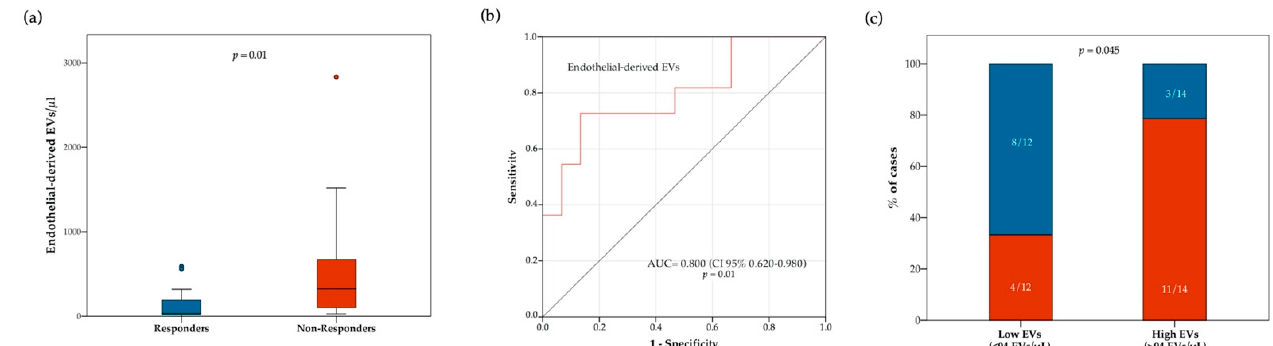
Figure 3. Relationship between response to ICIs and blood circulating endothelial-derived EV concentration at treatment baseline. In panel ( a ), boxplot diagram showing difference in median endothelial-derived EV concentration (horizontal black lines) between responders and non-responders. Two-tailed Mann–Whitney test was performed, and p value is shown. In panel ( b ), receiver operating characteristic (ROC) curve illustrating predictive abilities on ICI response of blood circulating endothelial-derived EVs. In panel ( c ), histograms showing difference in disease control rate (DCR) according to baseline endothelial-derived EV concentration (cut-off point: 94 EVs/ µ L). Blue and red bars indicate proportion of responders and non-responders, respectively. Fisher’s exact test was used to compare the two